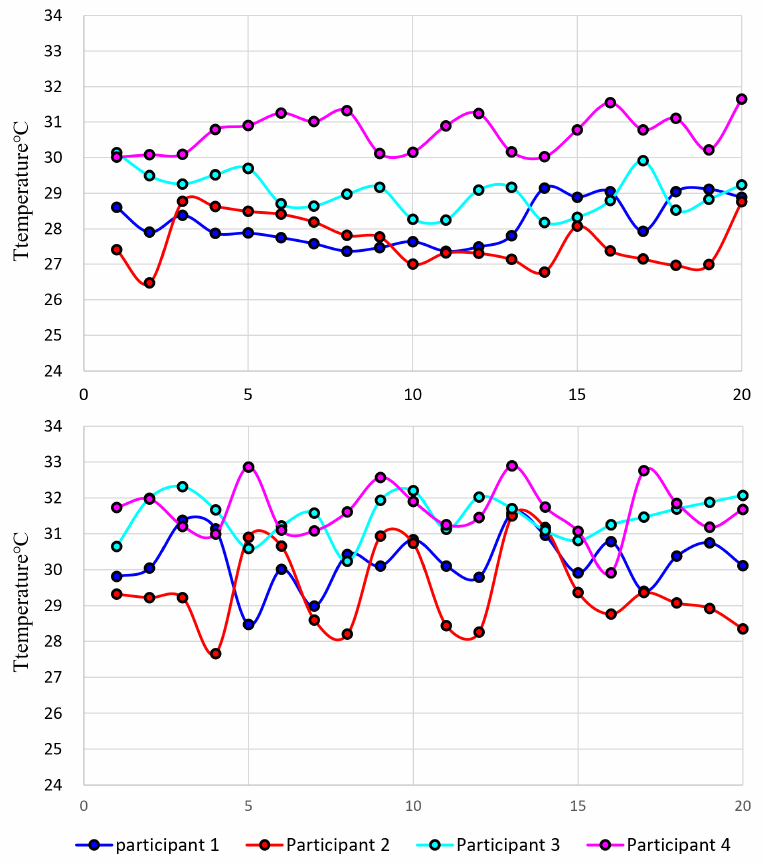
Figure 4. Graph of hot spot temperature by participant (Creation method: Top : exhalation using a hollow rod, bottom : fingertip touch) (Participant2: cold constitution of hands and